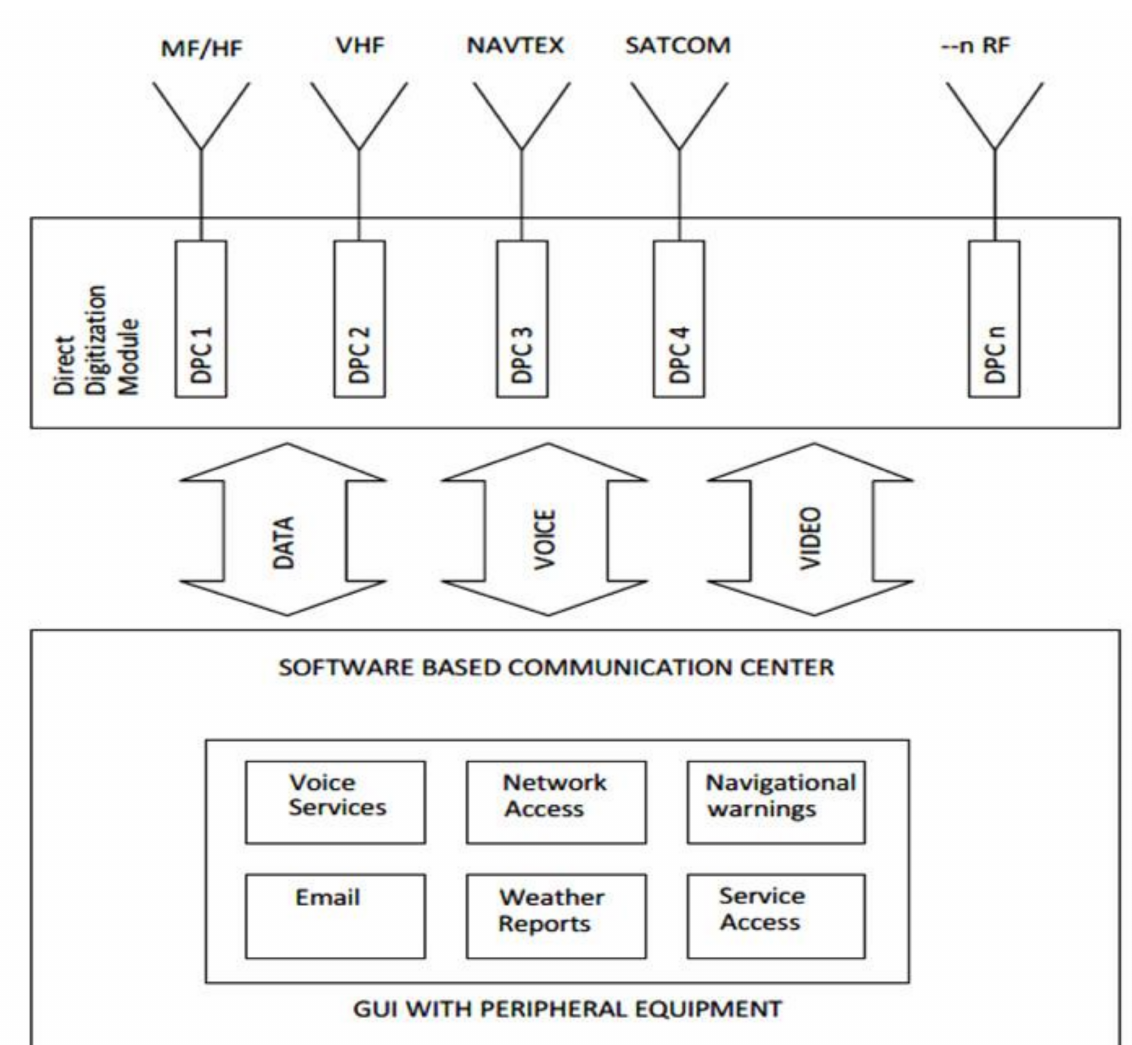
Figure 7. Model of the maritime communications system based on the SDR